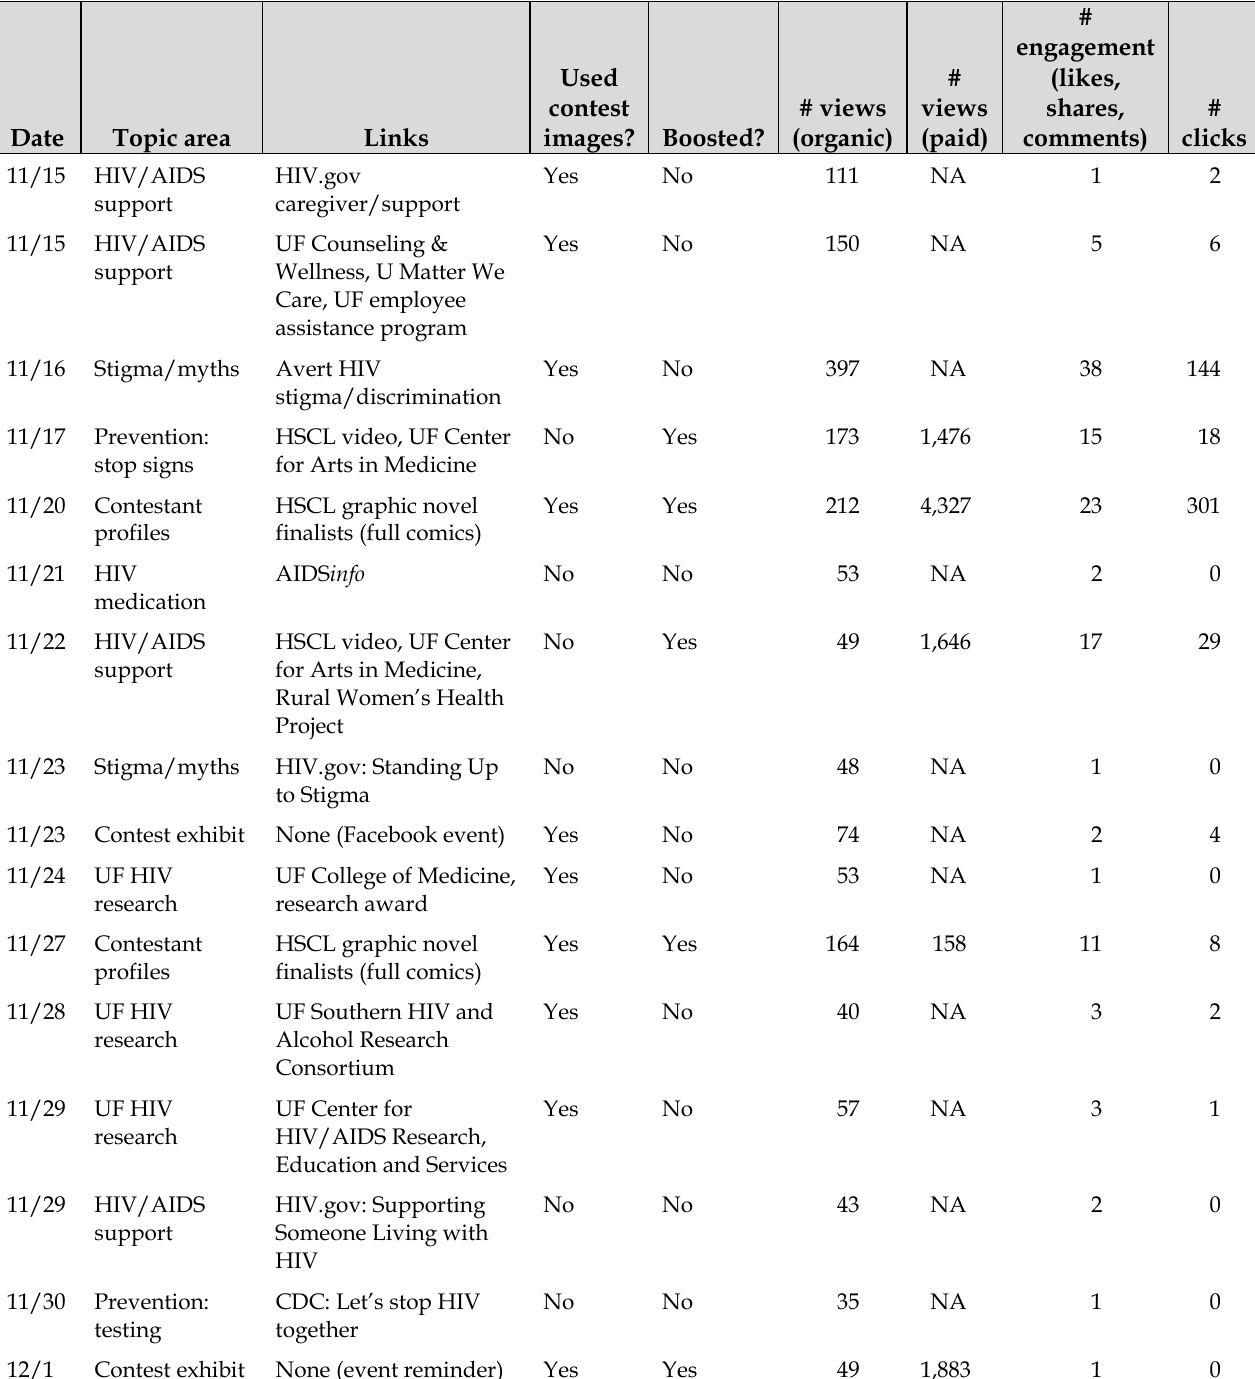
Table 1 Social media campaign posts, content, views, and engagement